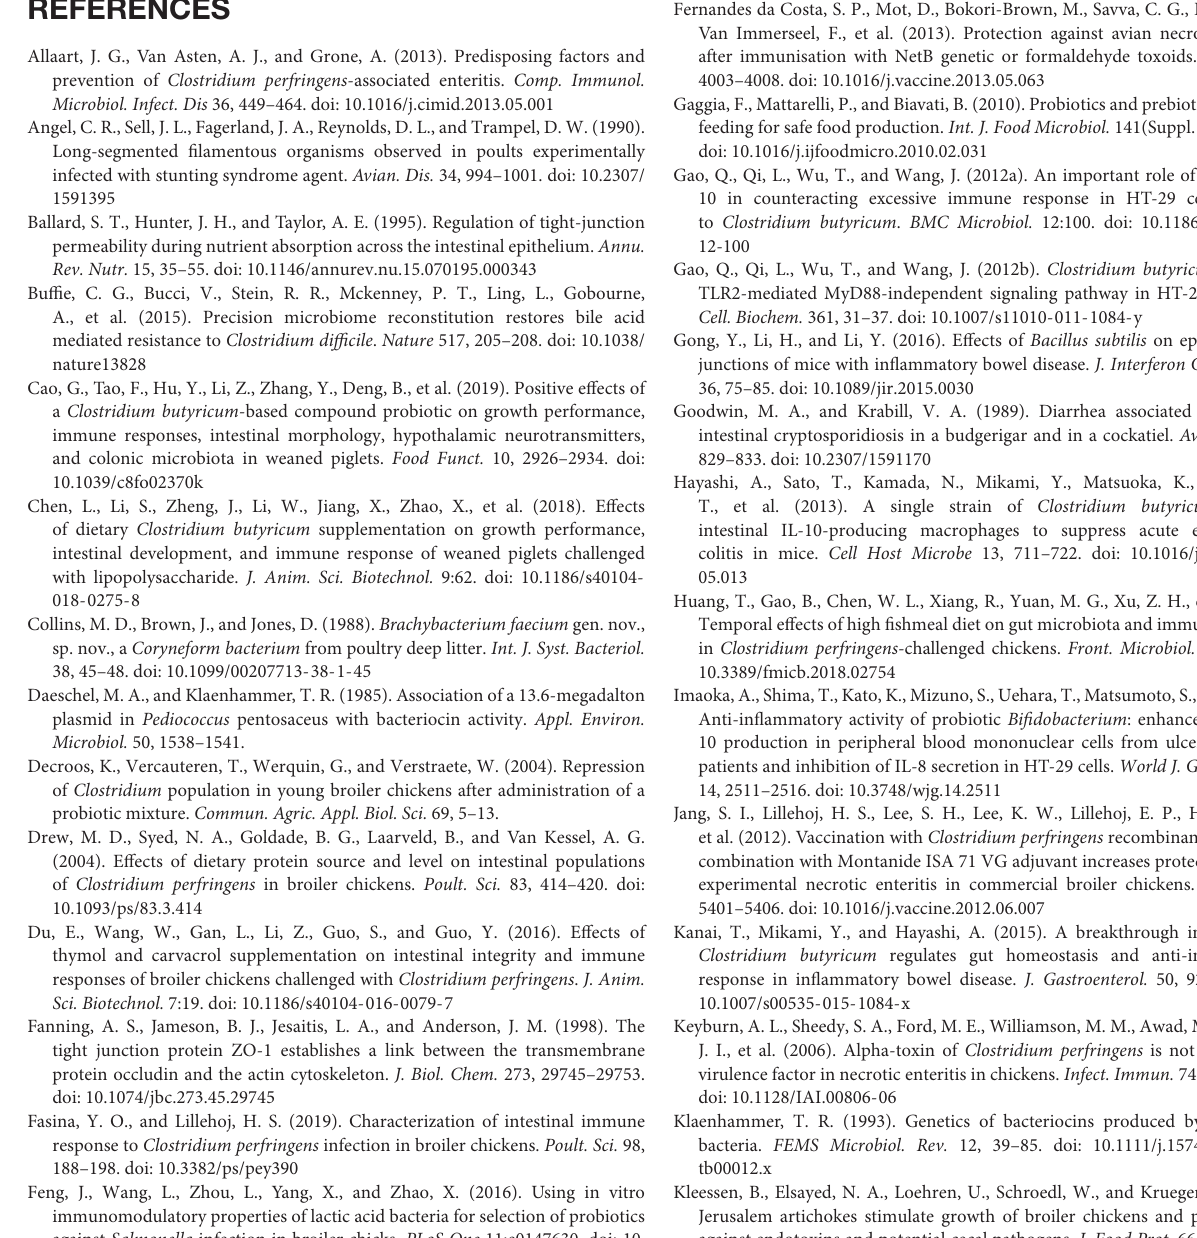
circles mark nodes that were also present in respective maximum-parsimony and neighbor-joining trees. Scale bar, 0.01 nucleotide substitutions per position. FIGURE S2 | Shifts in gut bacterial composition in different groups at order level. ∗ p < 0.05 measured using the Kruskal-Wallis test. CB_B, CK_B, CB_FM, and TABLE S1 | Composition and nutritive levels of the diets (air-dry basis, %). TABLE S2 | Primers used for qPCR. TABLE S3 | Relative intestinal microbiota abundances (%) of significantly different species on three different stage of chicken with